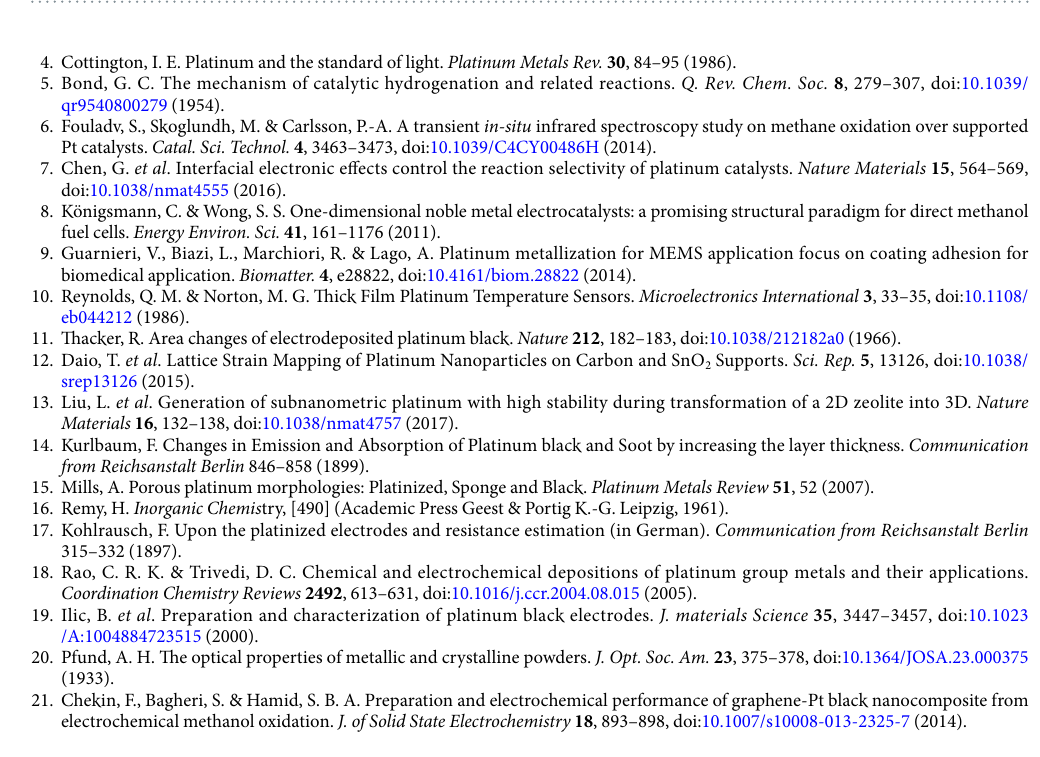
Figure 6. FTIR spectra of the electrosynthesized platinum black layer. ( a ) The photograph of one of the setup- section; ( b ) FTIR reflectance spectra of platinum black on Pt, Al, stainless steel, Sn, Cu alloy, Ag, and Au. ( c , d ) Transmittance and reflectance FTIR spectra of the platinum electrochemically deposited on Indium-Tin Oxide (ITO) substrate. Reflectance reference: aluminum mirror; transmitance reference: